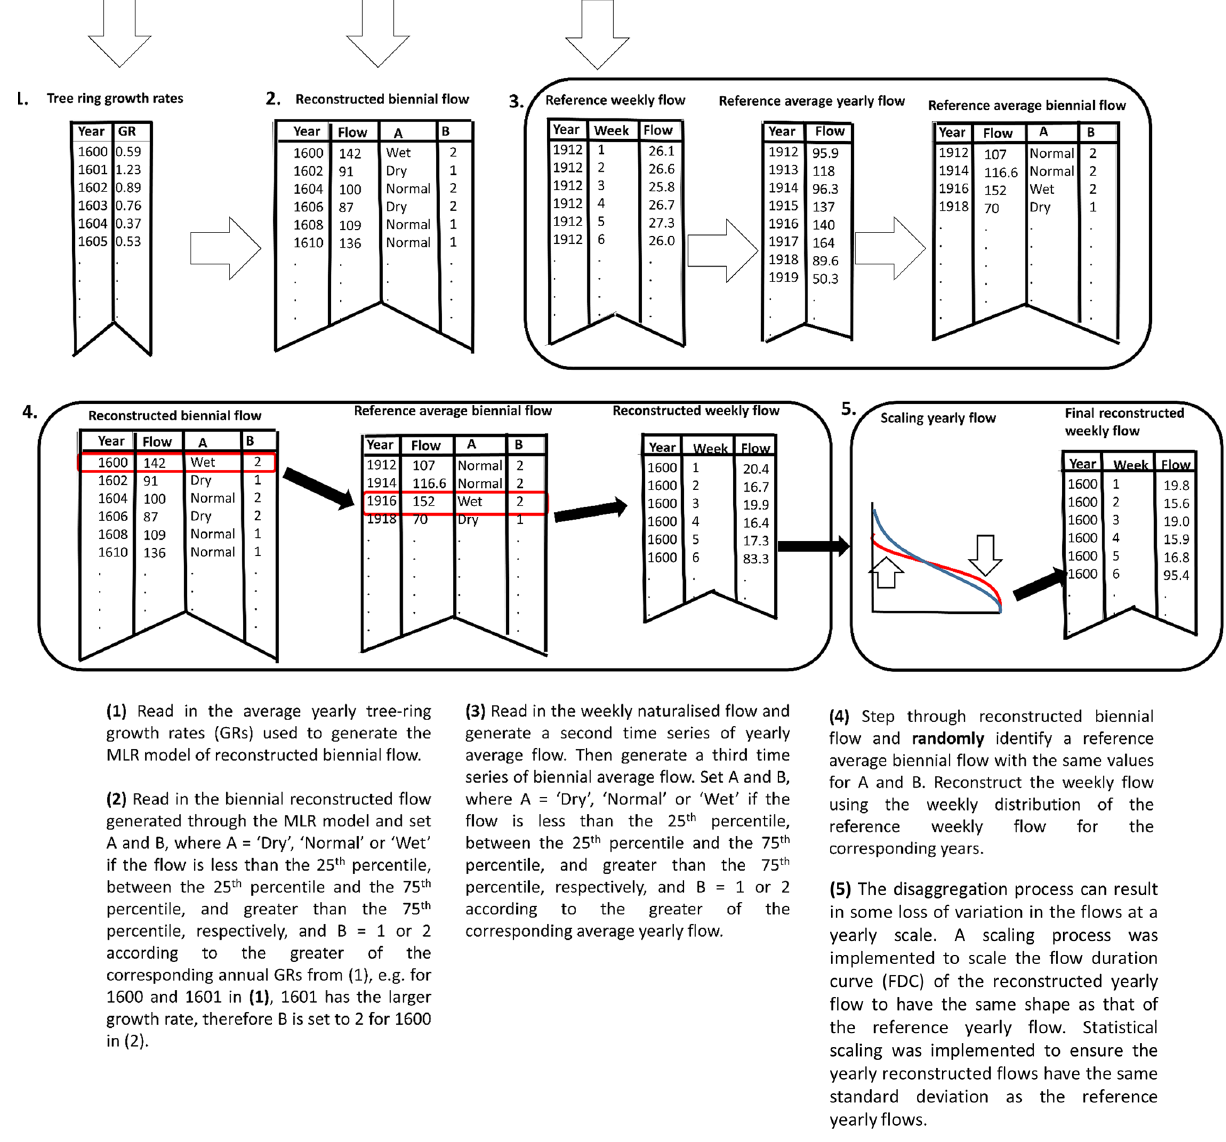
Figure 2. Conceptual representation of the process for disaggregating 2-year (biennial) tree-ring reconstructed streamflow to weekly recon- structed